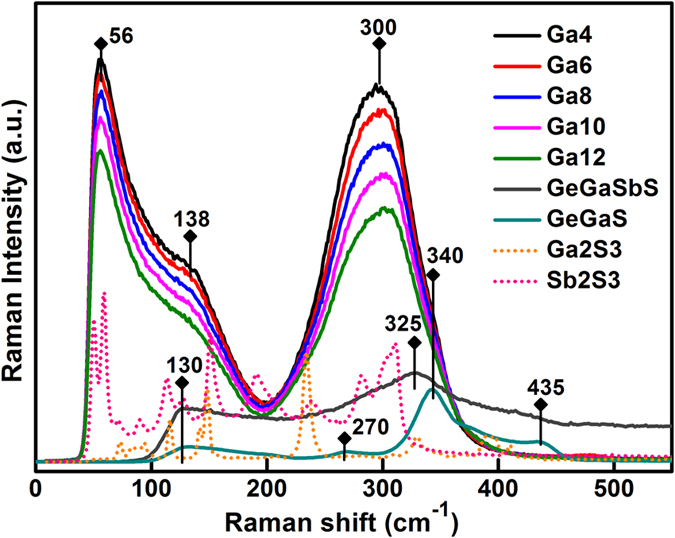
Raman spectra of GSS host glasses with different Ga concentrations and the corresponding reference samples including Ga2S3, Sb2S3 crystals, and GeGaS, GeGaSbS glasses.